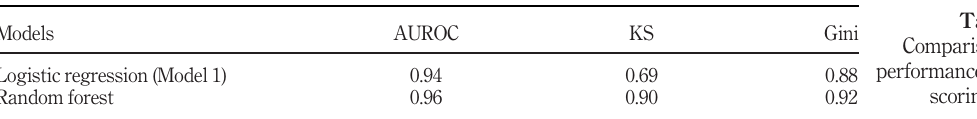
Table VII. Comparison of the